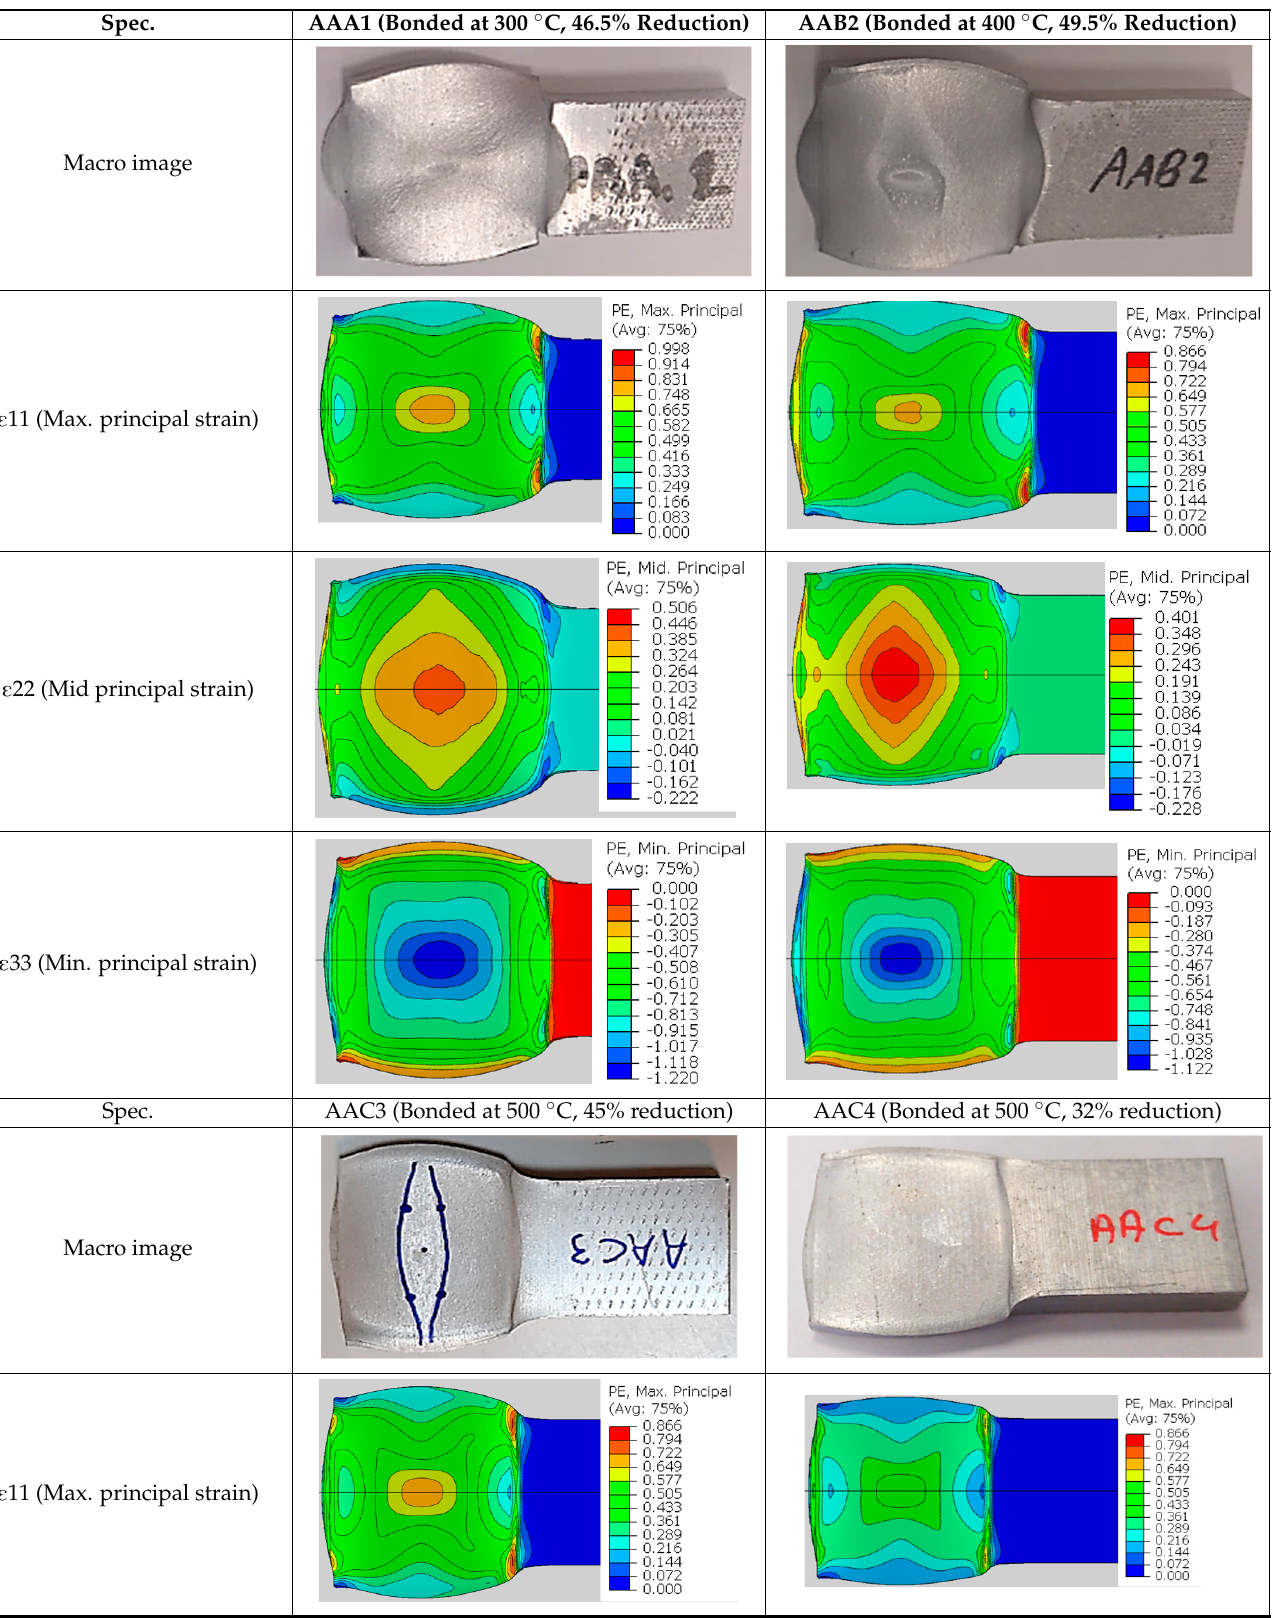
Figure 8. Areas of interest where the different values of bonding quality parameter J where com- puted.